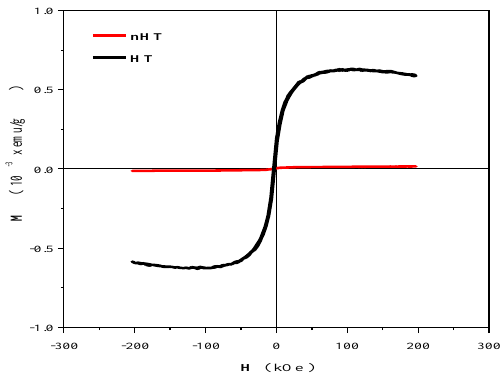
Figure 3. Magnetization curves measured at 9 T and 300 K for the sample under heat treatment reduction at 650 °C and non-heat treatment